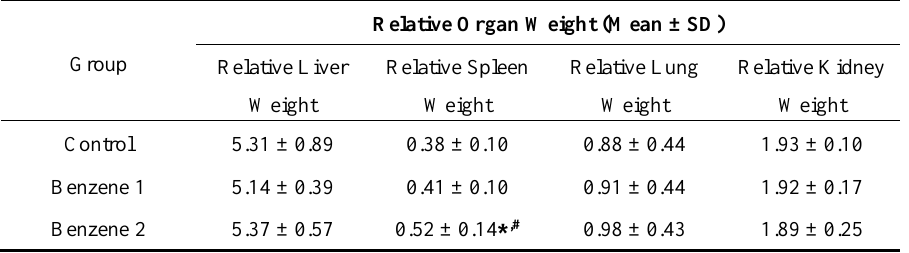
Table 2. Relative organ weight of mice at 10 months post-benzene exposure. Relative Organ Weight (Mean ± SD) Group Relative Liver Relative Spleen Relative Lung Relative Kidney Weight Weight Weight Weight Control 5.31 ± 0.89 0.38 ± 0.10 5.14 ±